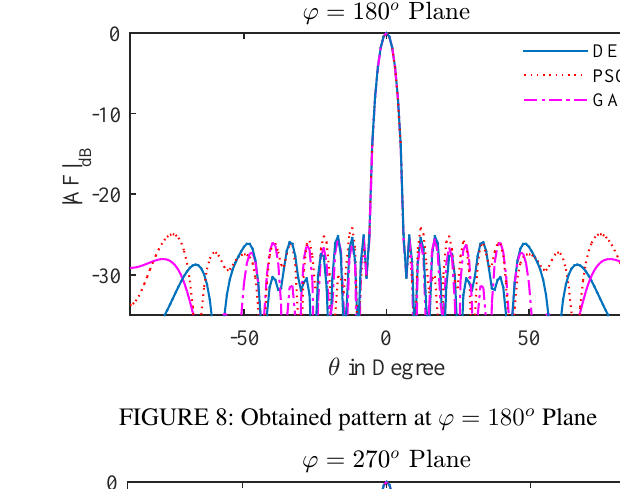
FIGURE 8: Obtained pattern at ϕ = 180 o Plane